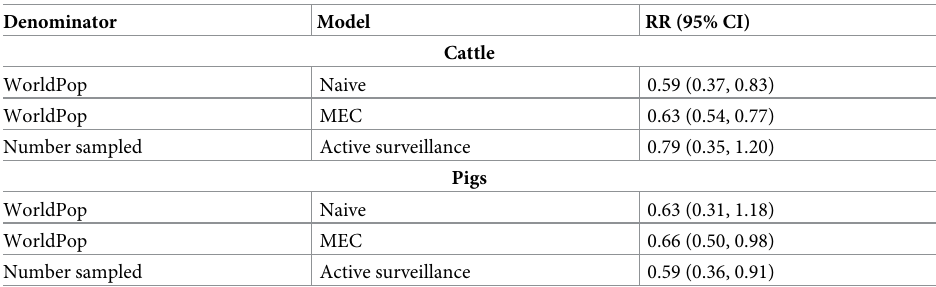
Table 4. Total effect results, South